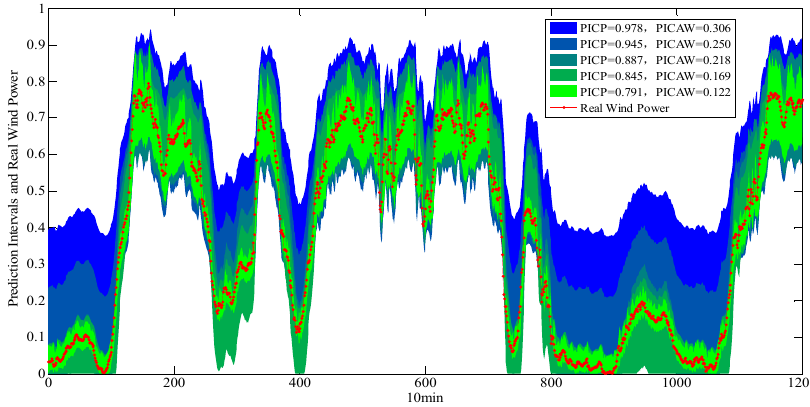
η= η= . CWC: coverage width-based η= . CWC: coverage width-based . CWC: coverage width-based PICP=0.979 ， PICAW=0.298 PICP=0.944 ， PICAW=0.257 PICP=0.923 ， PICAW=0.171 PICP=0.865 ， PICAW=0.141